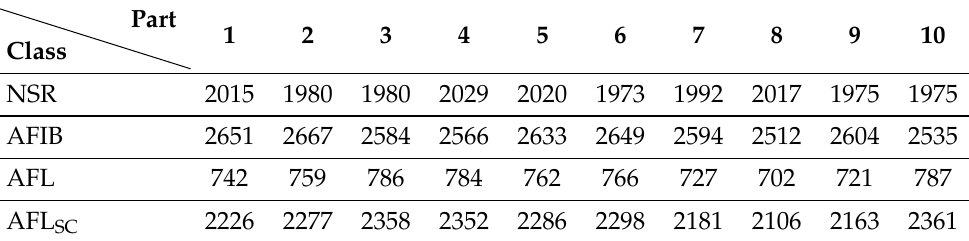
Table 2. The number of RR intervals per signal class in each part. AFL SC denotes the scrambled AFL